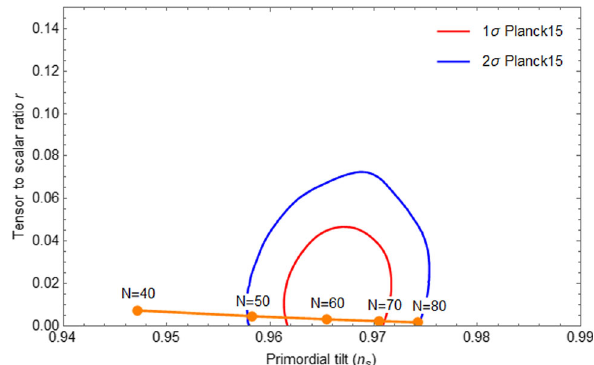
Fig. 1 Wecomparethetheoreticalpredictionsoftheweaklimit Q (cid:2) 1 given in Eqs. (3.4) and (3.5) in the ( r − n s ) plane for different values of N using C r = 70 and C 1 = 2 . 0 × 10 − 7 with Planck’18 results for TT, TE, EE,